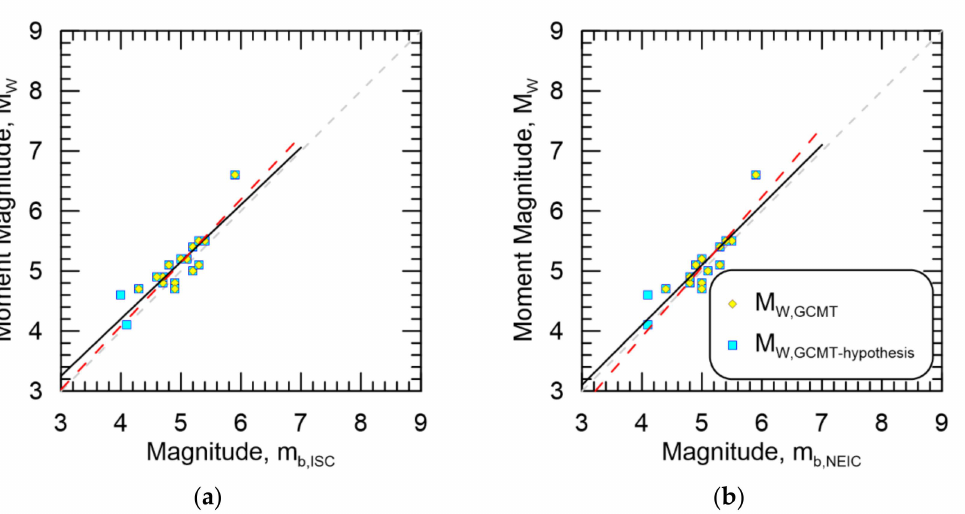
Figure 13. Resultant magnitude homogenization regressions for M W,GCMT-hypothesis against ( a ) m b,ISC and ( b ) m b,NEIC . Data from M W,GCMT are also shown. Black line is the regression against M W,GCMT-hypothesis while the dashed red line is the regression against M W,GCMT . The resultant magnitude homogenization regressions for M L,KMA are shown in Table